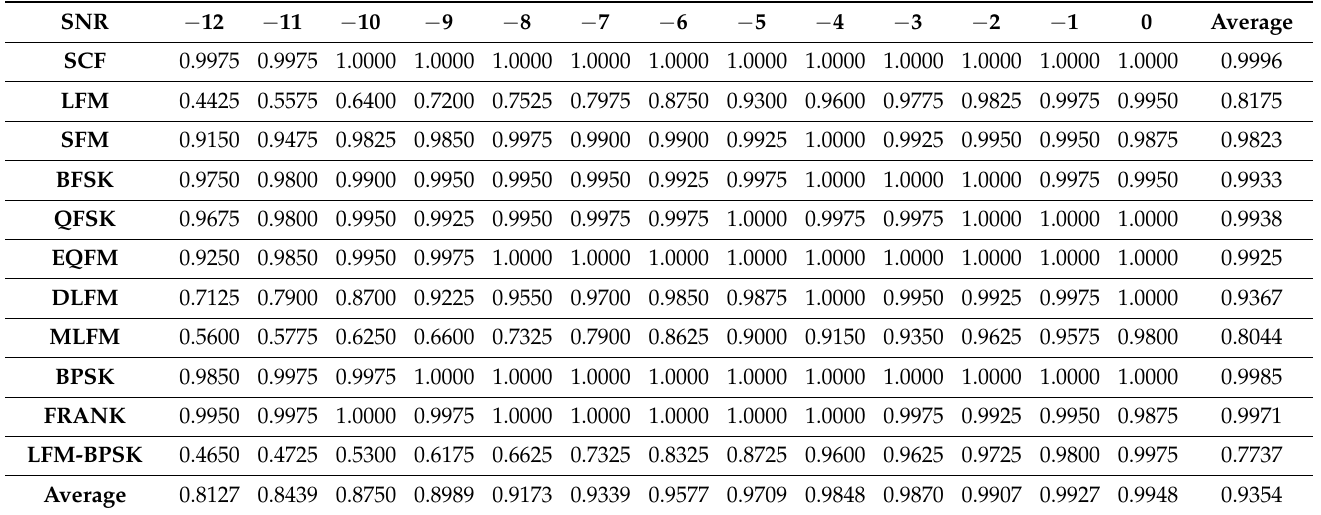
Table A3. The fully supervised classification results with the datasets in Situation Dataset 3.